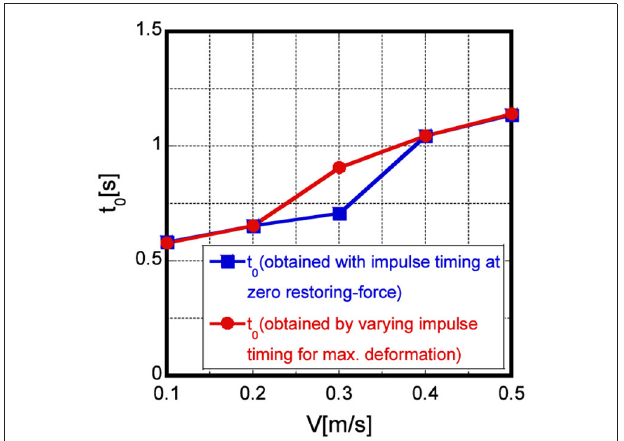
FIGURE 10 | Comparison of critical time intervals for input level calculated with impulse timing at zero restoring force and varied for maximum deformation [Model (a)].